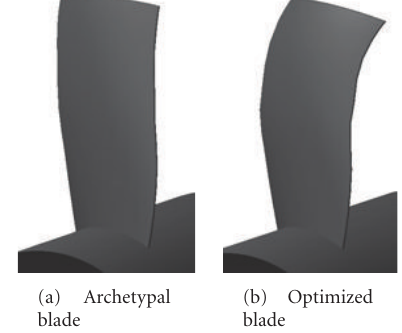
Figure 8: 3D models of archetypal blade and optimized